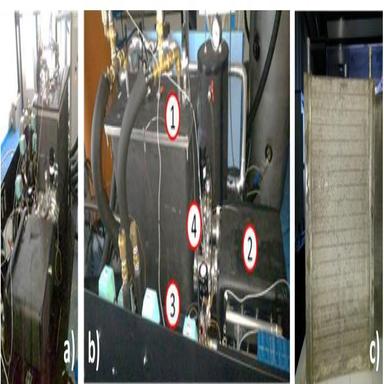
Lab-scale adsorption TES: (a) side view; (b) frontal view. (1) adsorber chamber, (2) evaporator/condenser chamber, (3) hydraulic circuit, (4) vacuum valve; (c) adsorber filled with LiCl (52)/vermiculite grains.